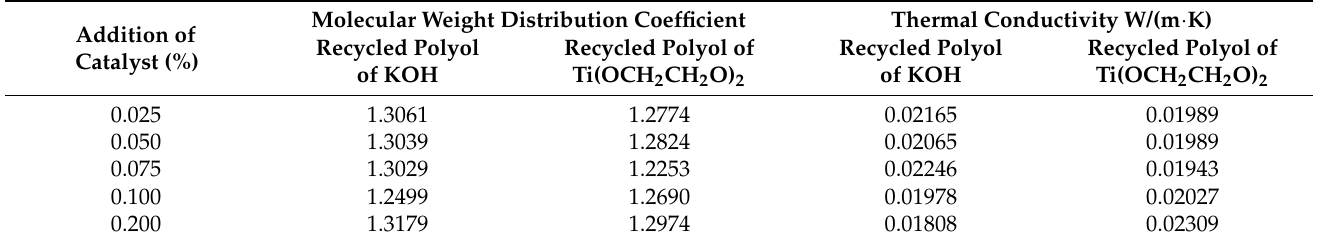
Table 2. Molecular weight distribution coefficient of recycled polyether polyols recovered under different catalytic systems.